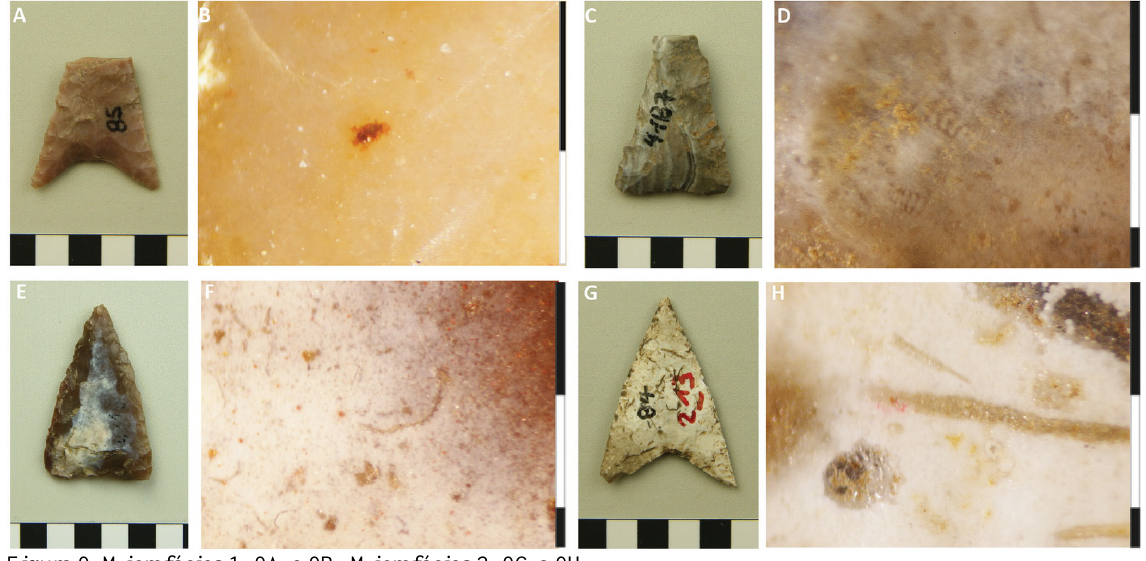
Figura 9. Microfácies 1: 9A e 9B; Microfácies 2: 9C a 9H. Figure 9. Microfacies 1: 9A and 9B; Microfacies 2: 9C to 9H. Microfácies 3 (M3): textura mudstone ou packstone, com presença de